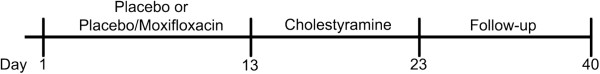
The study design. Subjects were administered placebo from day 1 to 12 of the study or placebo from day 1 to 12 and single dose 400 mg Moxifloxacin (Moxi) on day 12, followed by a washout phase with cholestyramine from day 13 to 23.